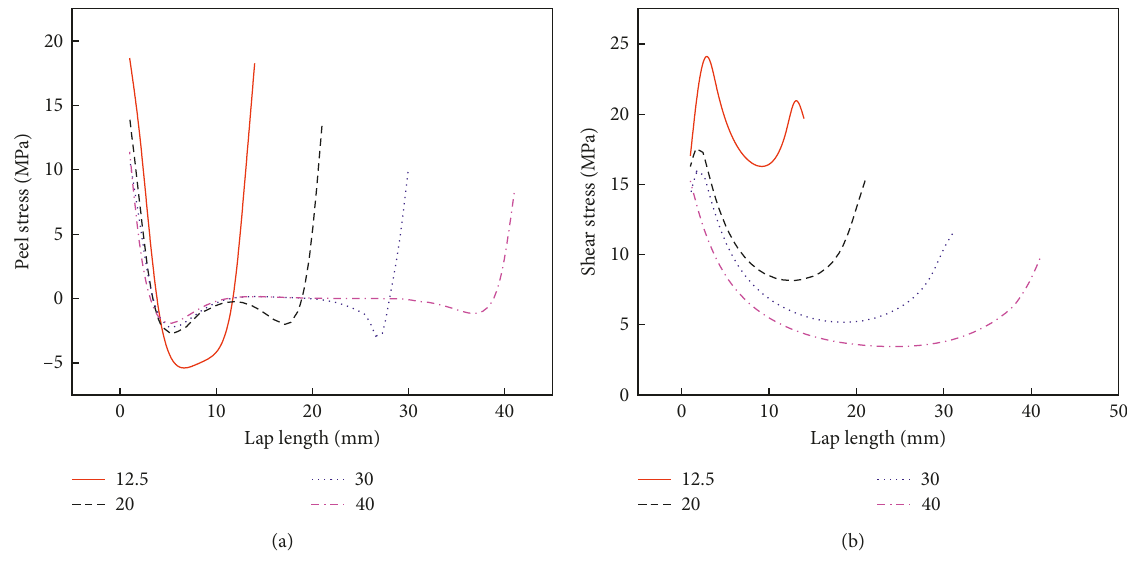
Figure 5: (a) Peel stress and (b) shear stress distributions with various overlap